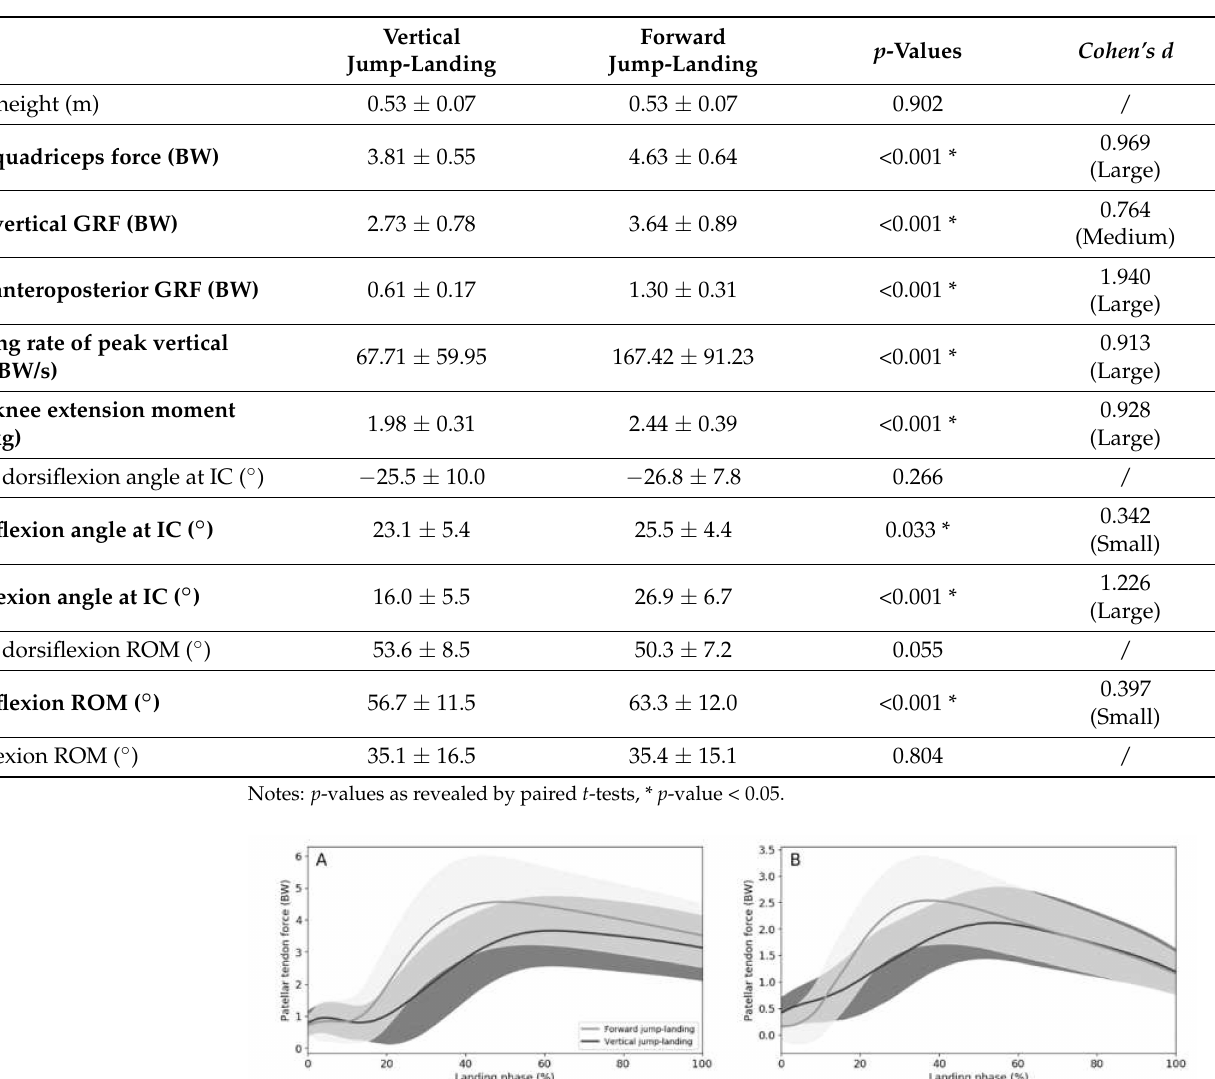
Table 2. Mean ± standard deviation of kinetic and kinematic parameters for volleyball players during vertical and forward jump-landings. IC: Initial contact, ROM: range of motion.